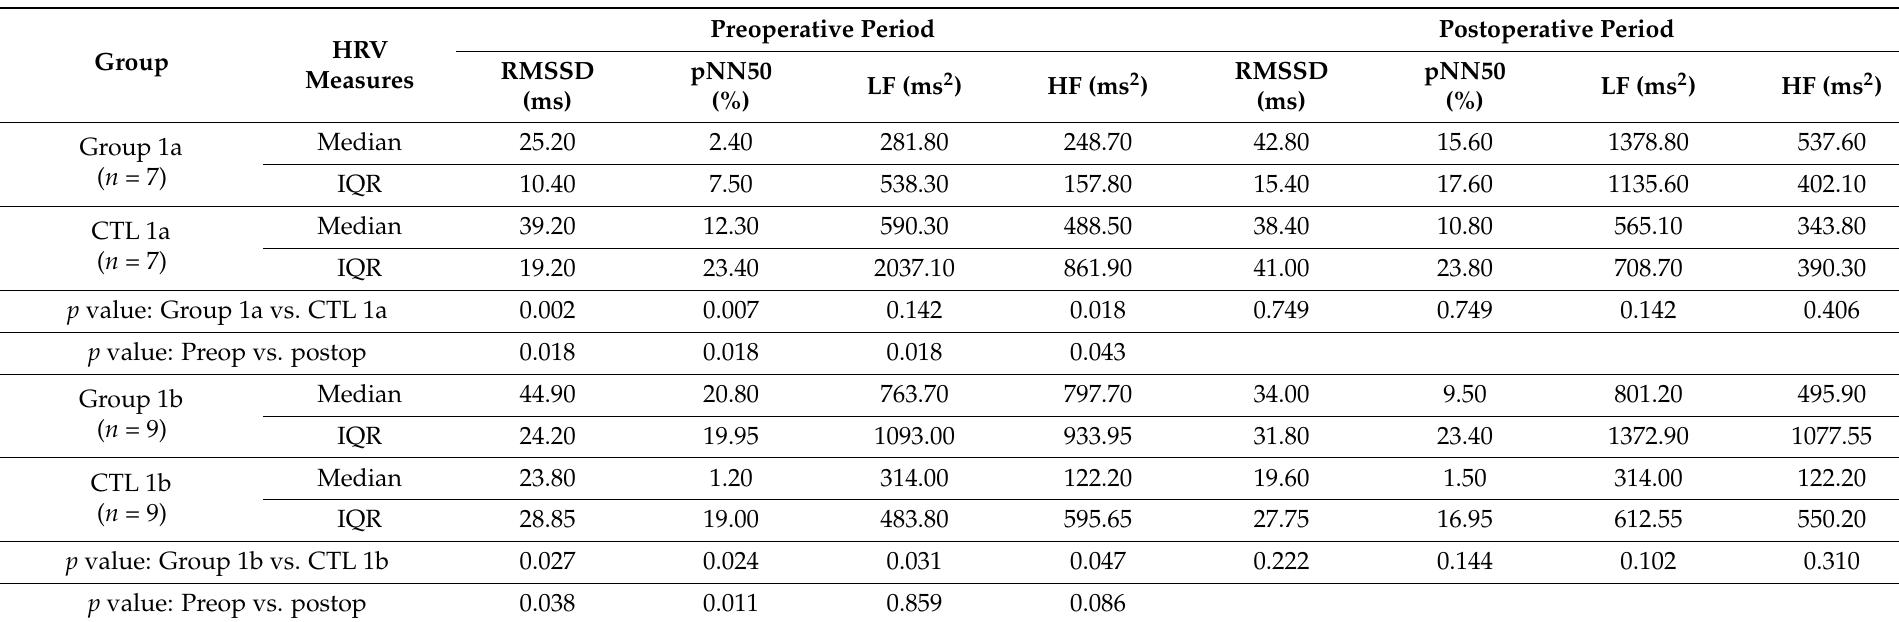
Table 5. Preoperative and postoperative HRV values of IOE subgroups compared to those of matched